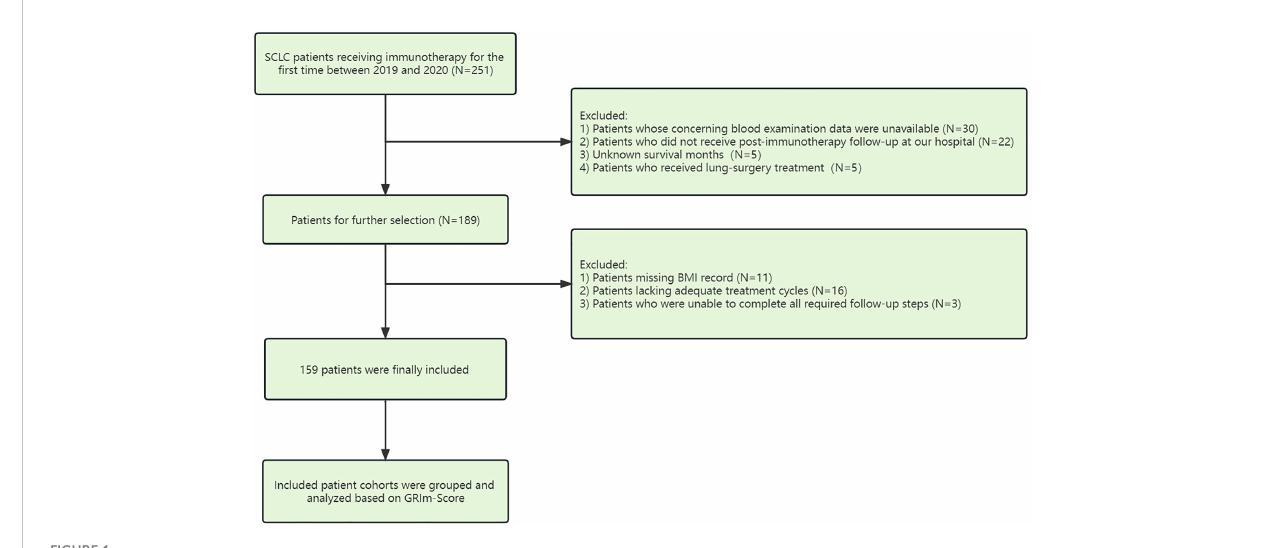
FIGURE 1 Flow diagram for the exclusion procedure of